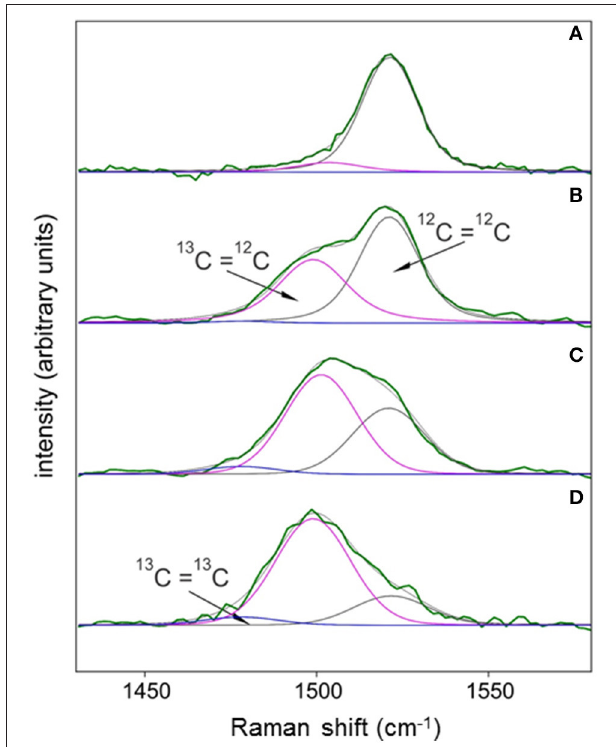
FIGURE 2 | Examples of the varying contributions of 12 C = 12 C, 12 C = 13 C, and 13 C = 13 C isotopologues to the shape, position, and areas of the ν (C = C) Raman spectral peak for carotenoids of cells assimilating varying amounts of DI 13 C. Each Raman spectrum was obtained from individual cells grown in either 0.011 f media (A) or 0.54 f media for 3 (B), 6.2 (C) , or 9.2 (D) days. Spectra were subjected to local baseline subtraction (1,360–1,660 cm − 1 ), intensity normalization (0–1), and a full Voigt curve-fitting routine (convolution of Lorentzian and Gaussian profiles) with 5,000 iterations or a 0.00001 tolerance